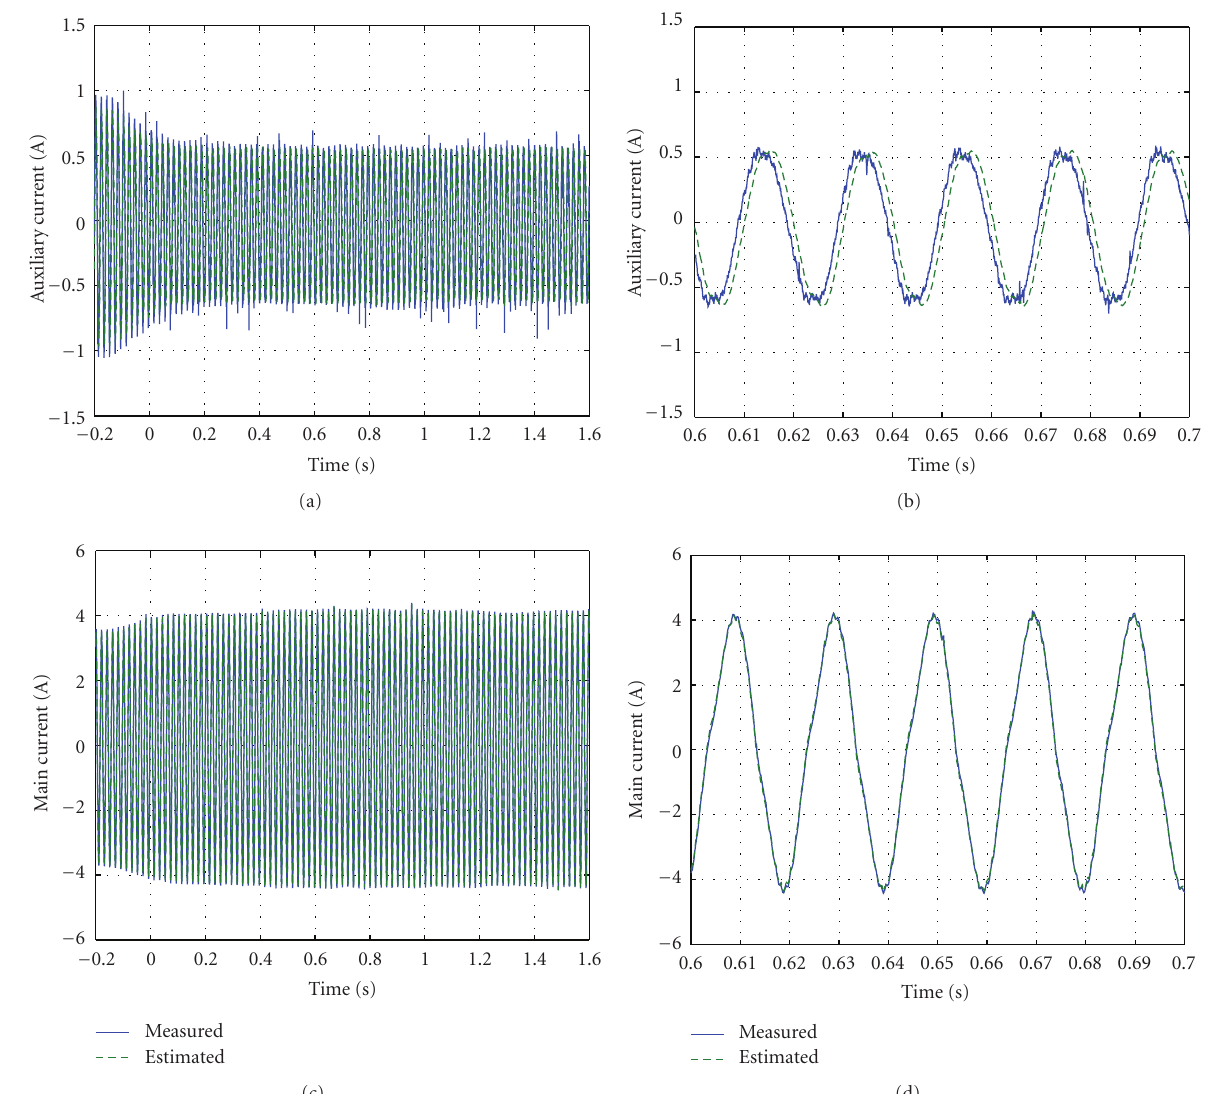
Figure 14: Measured and estimated stator currents of the SPIM when the rated mechanical load is applied (experimental results): (a) auxiliary winding i sα , (b) details of i sα , (c) main winding i sβ , (d) details of i sβ